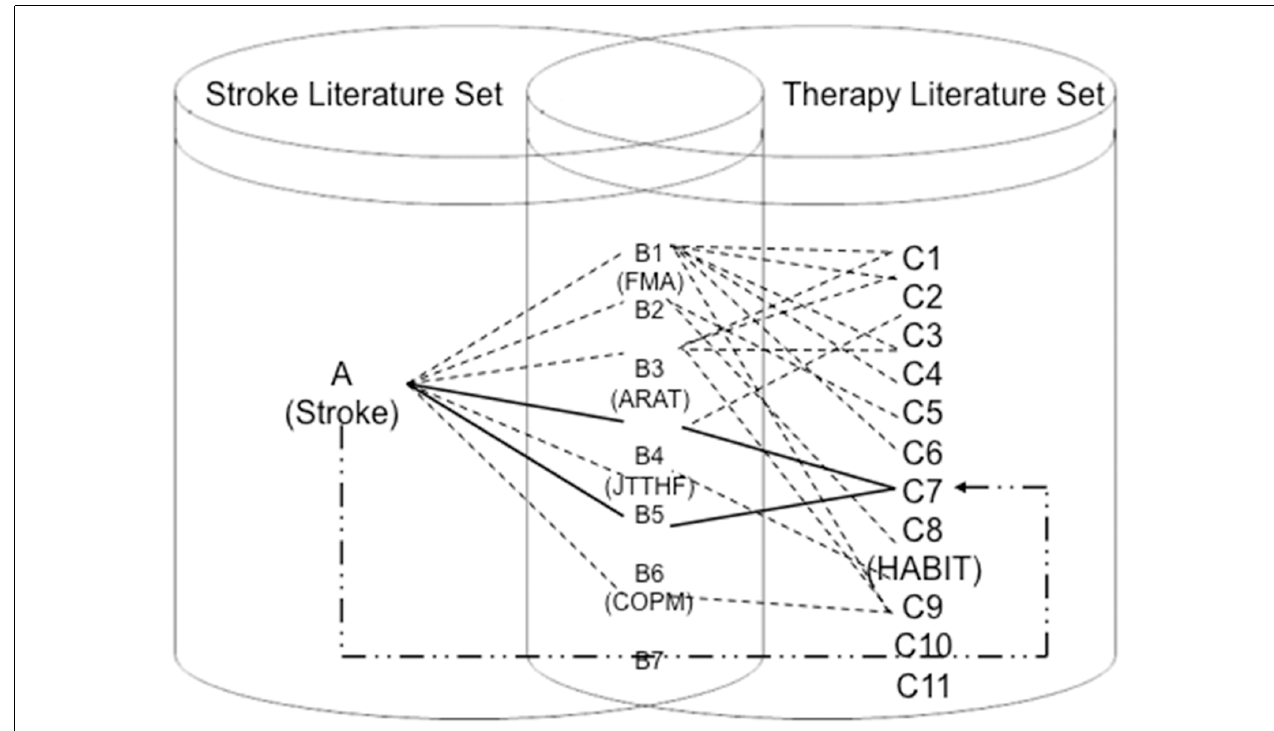
FIGURE 1 | ABC model of Stroke—Assessment scales—Rehabilitation therapies ... . Indicates a possible direct interaction between A (stroke), B (assessment scales), and C (therapies). __ Indicates a real direct interaction of stroke-assessment scales in this study. ... Indicates the pathway of stroke and the targeted therapy hand-arm bimanual intensive training (HABIT) in this